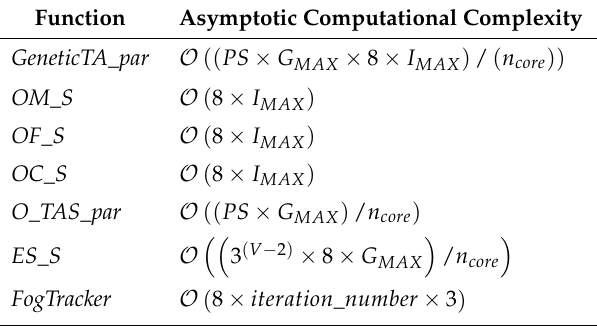
Table 4. A synoptic overview of the computational complexities of the main functions supported by the VirtFogSim